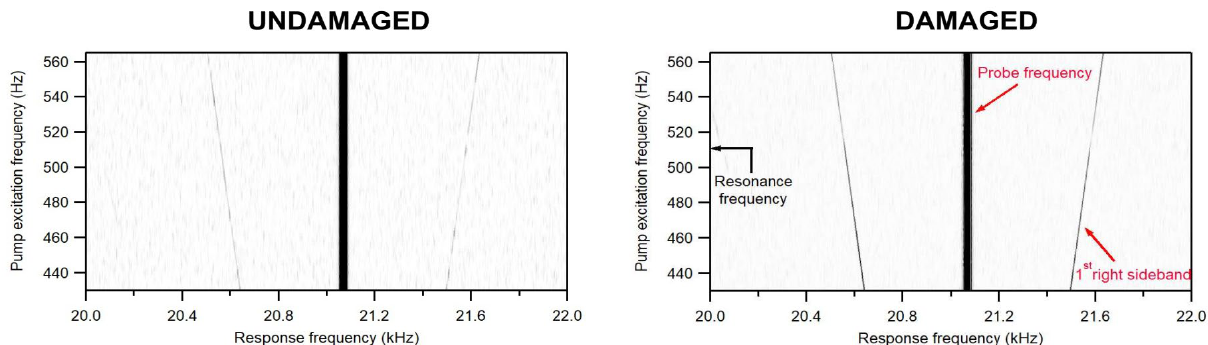
Figure 10. Spectrograms of the response of the beam to a swept pump excitation (frequency range 430–565 Hz) in the undamaged ( left ) and damaged ( right ) conditions.